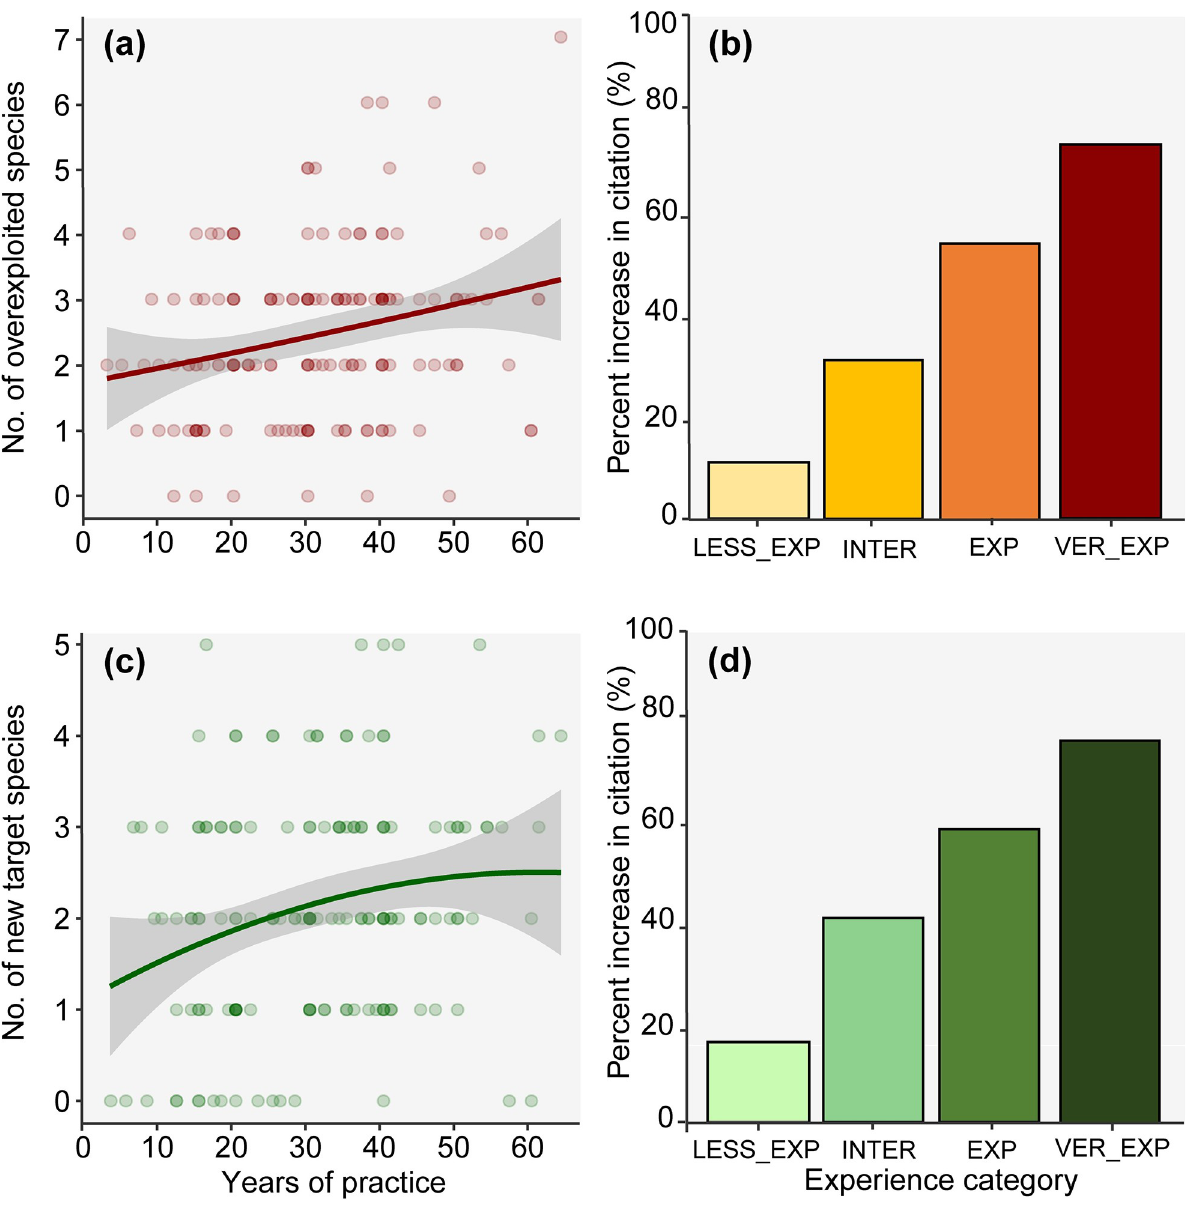
Fig 2. (a) Number of species mentioned as overexploited according to fisher’s experience (years of practice); (b) Probability of citations of overexploited species according to fisher’s experience; (c) Number of species mentioned as new target species according to fisher’s experience; and (d) Probability of citations of new target species according to fisher’s experience. Experience categories: LESS_EXP = less experienced; INTER = intermediate; EXP = experienced; and VER_EXP = very